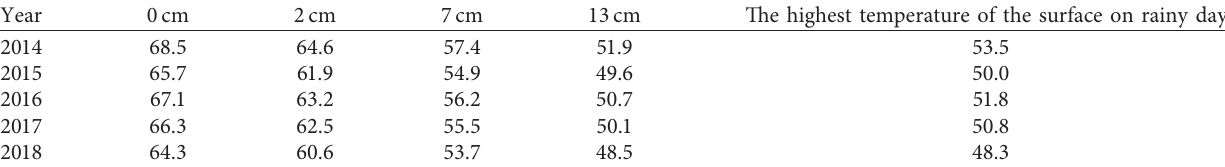
Table 3: The highest temperature at different depth in the pavement (unit: ° C).